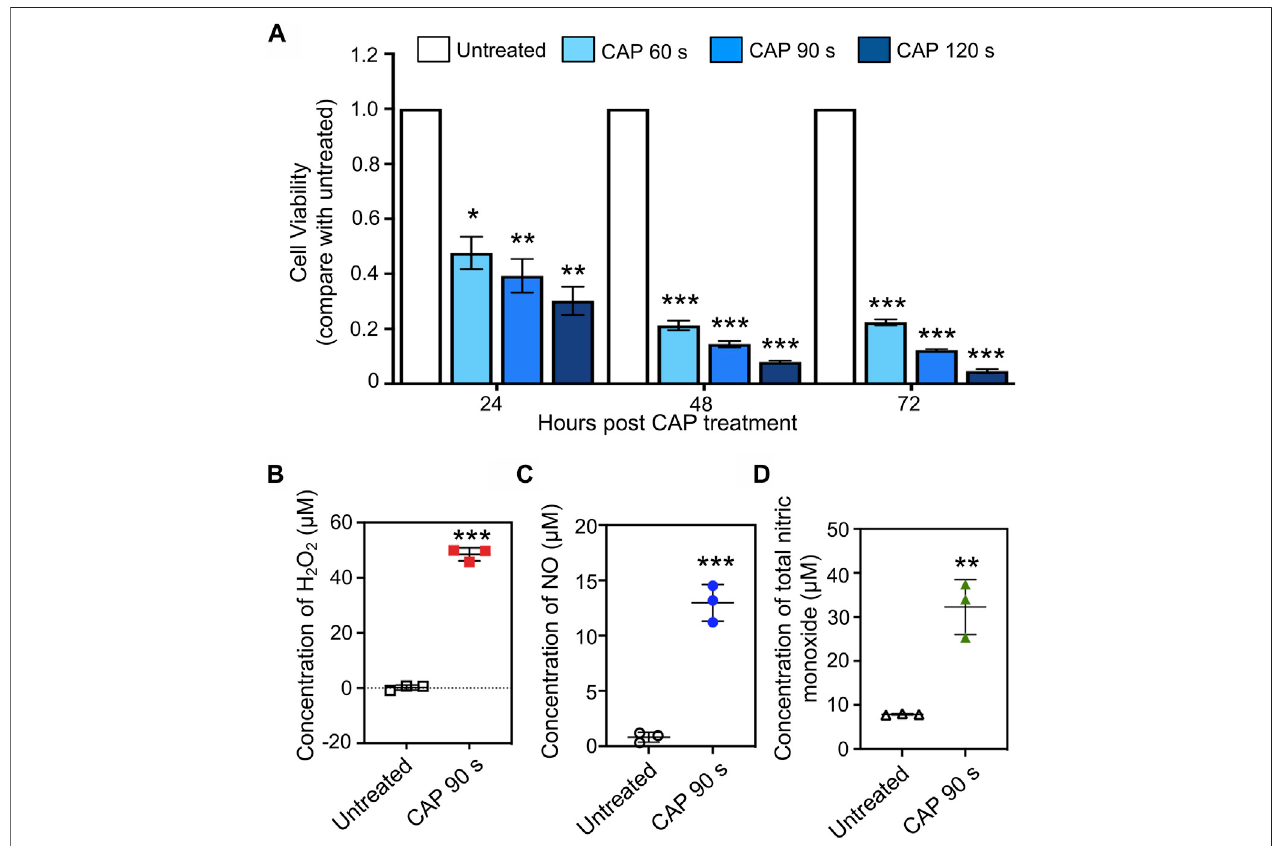
FIGURE 2 | In vitro anti-cancer effect and reactive species generation of CAP. (A) Cell viability of human chronic myeloid leukemia K562 cells at 24, 48, and 72 h post-CAPtreatmentindifferentperiods( n =5,* p < 0.05,** p < 0.01,*** p < 0.001). (B – D) H 2 O 2 ,NO,andtotalnitricmonoxideproductionincellculturemediumafter90 s of CAP treatment ( n = 3, ** p < 0.01, *** p < 0.001).